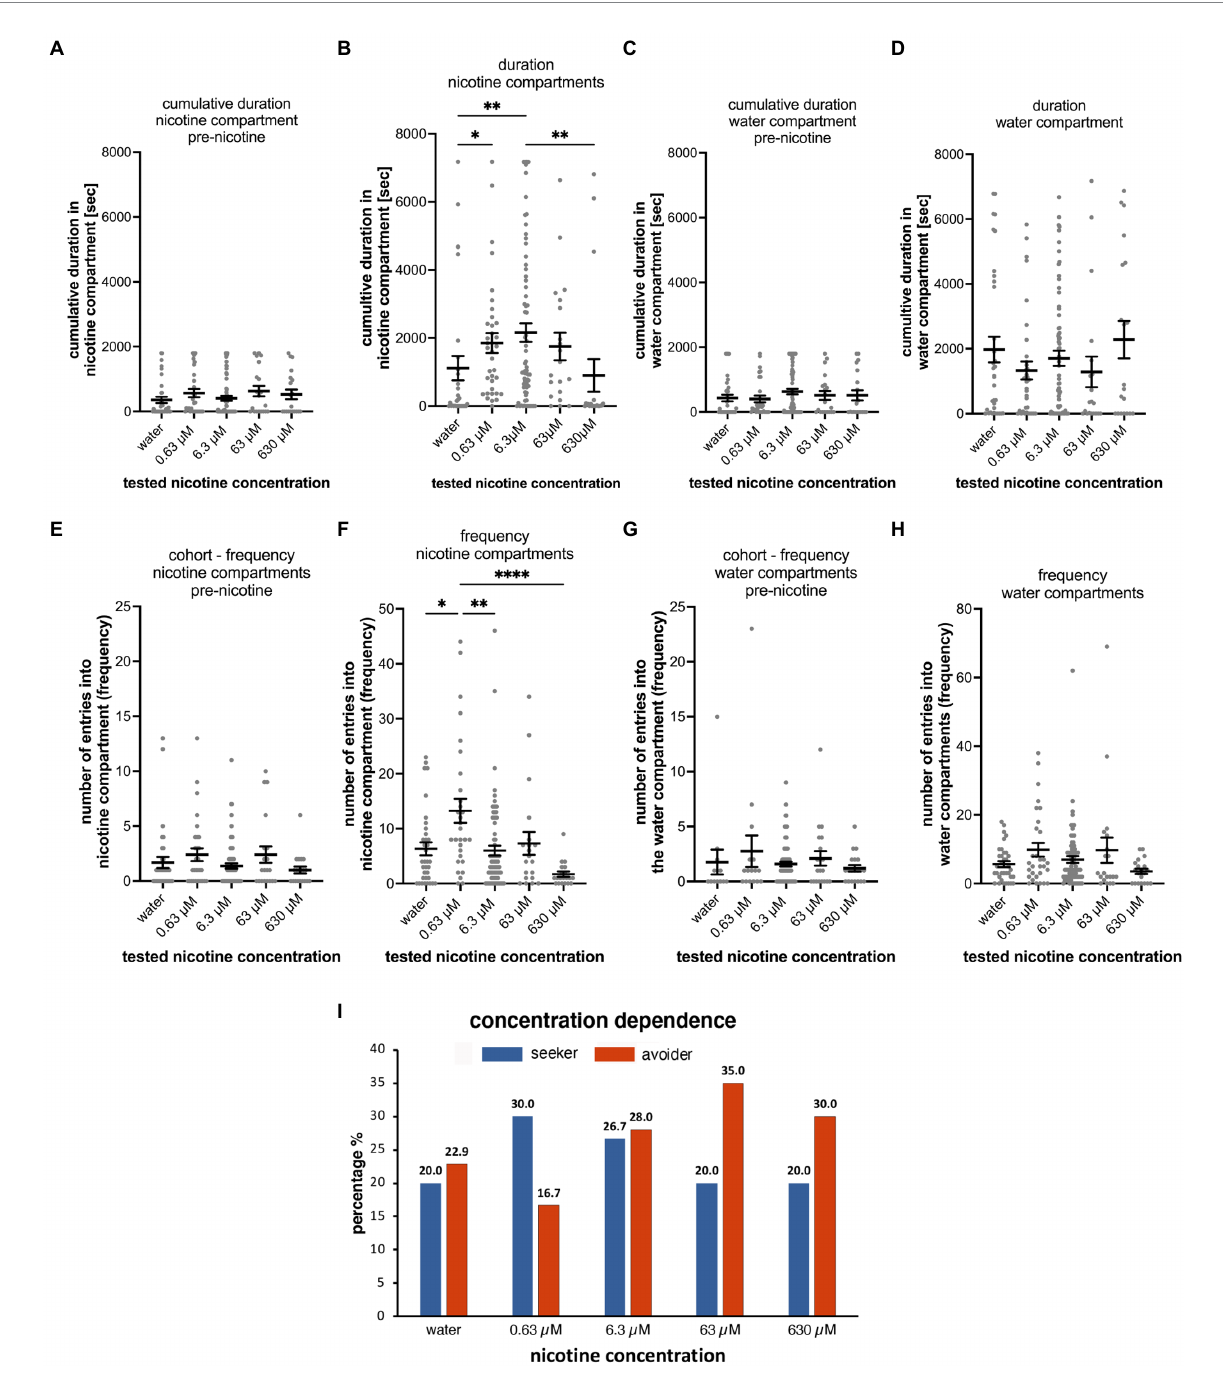
FIGURE 3 Concentration dependence of nicotine-seeking and avoidance in larval zebrafish. (A) Shows the duration spent in the “nicotine” compartment before the addition of nicotine (pre-nicotine). No significant differences ( p > 0.9999) were detected between water controls (water) and different nicotine concentrations (0.63, 6.3, 63 μ M nicotine, and 630 μ M nicotine) for the cumulative duration in the pre-nicotine phase of experiments. The duration of the pre-nicotine phase was 30 min compared to the duration of the 2-h nicotine phase after adding nicotine. (B) The concentration of nicotine increased the cumulative duration in the nicotine compartment compared to water controls for 0.63 μ M nicotine ( p = 0.0158), and for 6.3 μ M nicotine ( p = 0.0092), but not for 63 μ M nicotine ( p = 0.2627) and 630 μ M nicotine ( p > 0.9999). The difference in cumulative duration in 630 μ M nicotine decreased significantly ( p = 0.0015) compared to the 6.3 μ M nicotine concentration. No significant differences in the cumulative duration in the water compartment were apparent in the 30-min pre-nicotine phase (C) and the 2-h nicotine phase (D) of the experiments. (E) The number of entrances into the “nicotine” compartment (frequency) before the addition of nicotine (pre-nicotine) were not significantly different. (F) After the addition of nicotine at a final concentration as indicated (0.63, 6.3, 63, and 630 μ M) compared to water controls (water) the number of entrances increased in 0.63 μ M nicotine ( p < 0.0001), but not in 6.3 μ M nicotine ( p = 0.7926), 63 μ M nicotine ( p > 0.9999) and 630 μ M nicotine ( p > 0.9999). The number of entrances into the water compartment (frequency) before the addition of nicotine ( G , pre-nicotine) and after the addition of nicotine (H) at tested concentrations were not significantly different. Data are shown as mean ±SEM. Statistical significance was tested using a Kruskal–Wallis test with Dunn’s comparison test.